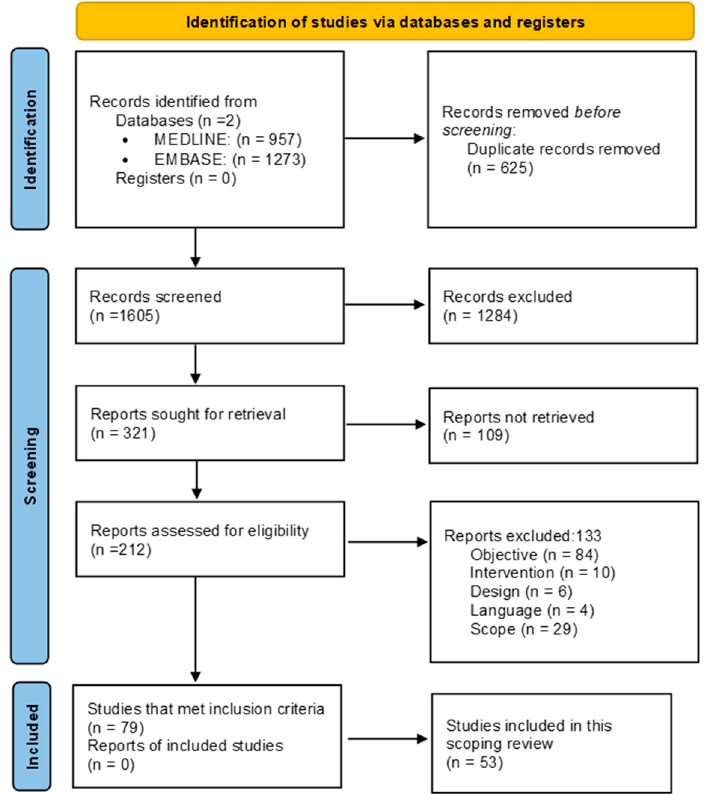
Figure 1. PRISMA flowchart of the study selection process.